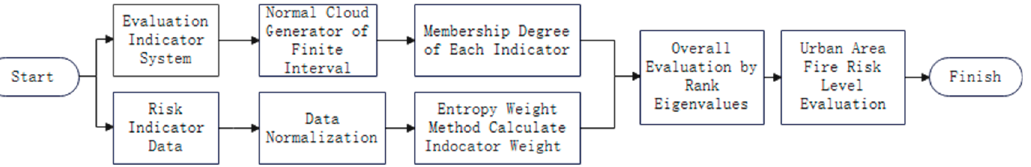
Figure 3. Procedure of urban fire risk evaluation.